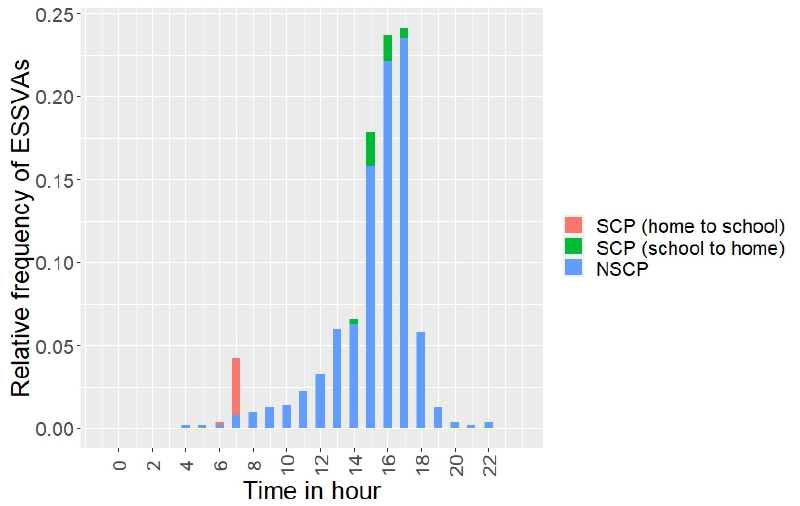
Figure 3. Time distribution of the occurrences of ESSVAs in the target area by travel purpose.